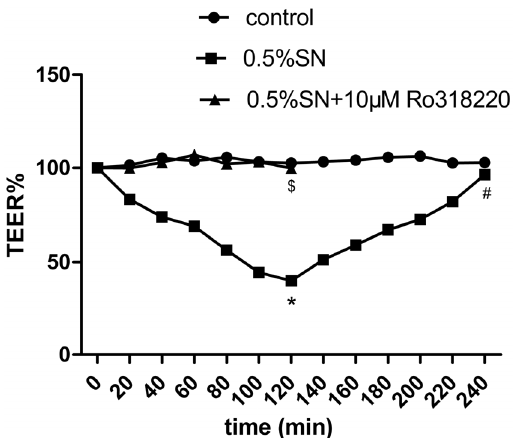
Figure 3. Effects of SN on the TEER (% relative to initial value) of polarized Caco-2 cell monolayers. The lowest point of the TEER% curve appeared at 120 min in 0.5% SN treatment group, which showed the reduce of TEER, an indication of TJs opening between Caco-2 cells. * p (0.5% SN treatment group vs . control group at 120 min) < 0.05, # p (0.5% SN treatment group vs . control group at 240 min) > 0.05, $ p (0.5% SN + 10 μ M